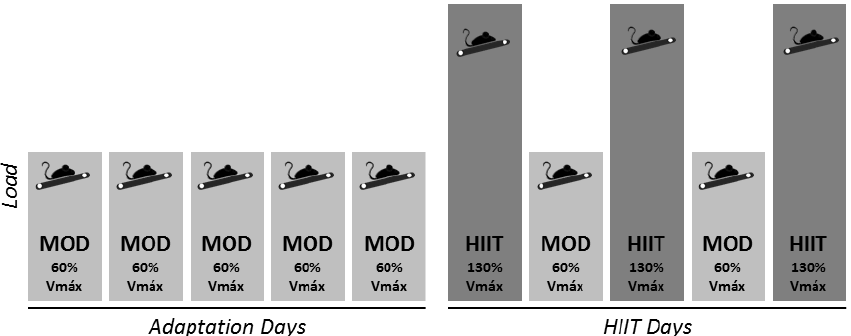
Figure 1. Experimental design. After one week adaptation in continue moderate intensity, one group exercised one week with high-intensity interval training (HIIT), while the other group exercised five weeks with HIIT. HIIT intensity was around 130% of the maximum speed and moderate intensity was around 60% of the maximum speed achieved in the incremental load test.